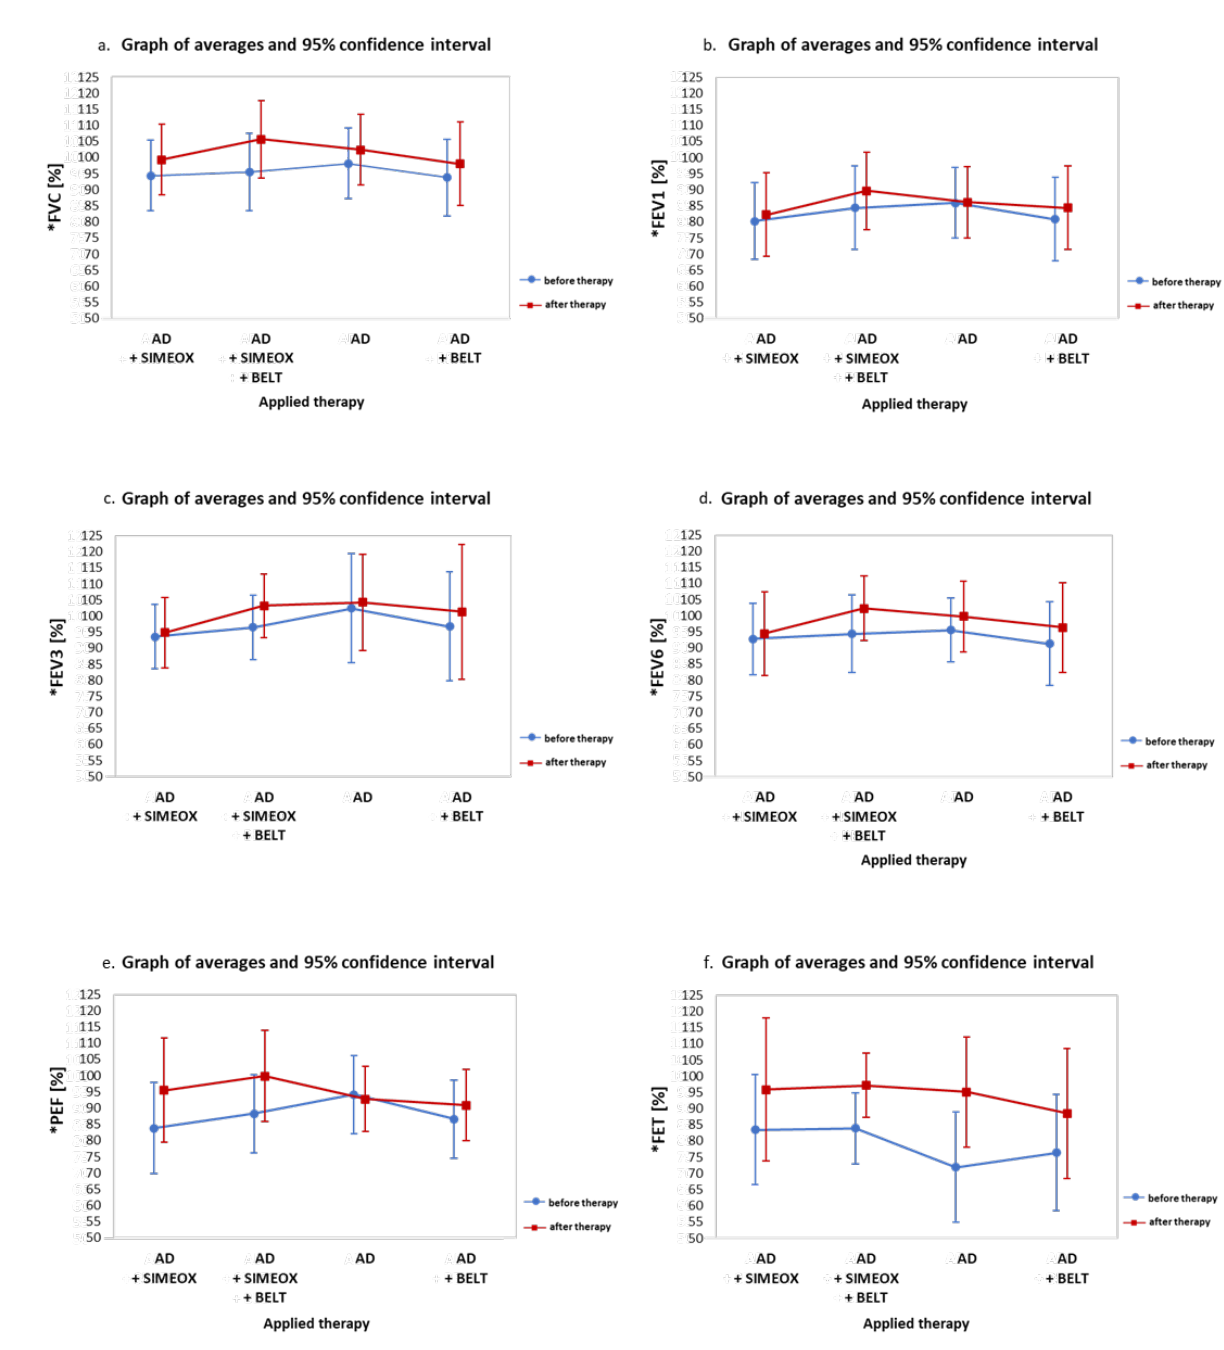
Figure 1. Graphic representation of ( a ) forced vital capacity (FVC); ( b ) forced expiratory volume in 1 s (FEV1); ( c ) forced expiratory volume in 3 s (FEV3); ( d ) forced expiratory volume in 6 s (FEV6); ( e ) peak expiratory flow (PEF); and ( f ) peak expiratory time (FET) before and after therapy. * AD, autogenic drainage.